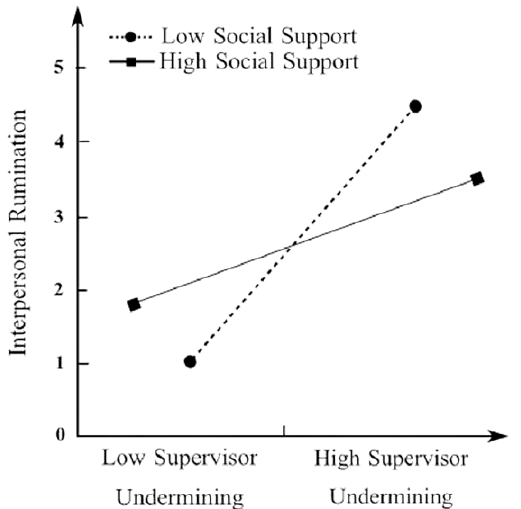
Figure 3. Interactive effect of unit supervisor social undermining and unit social support on interpersonal rumination.